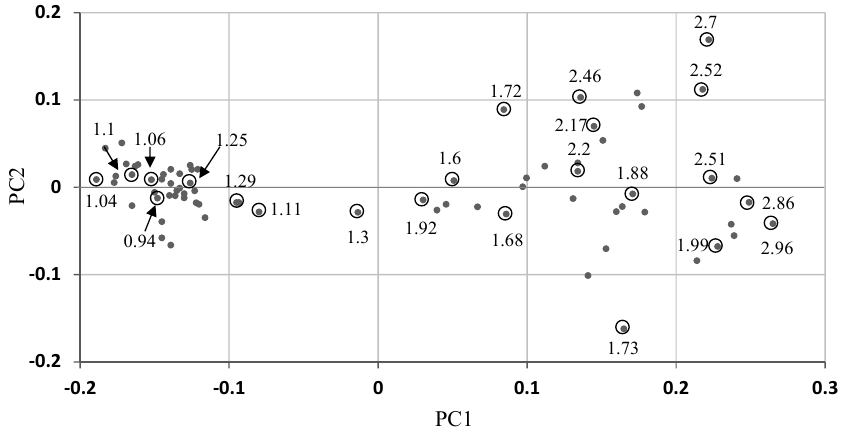
Figure 6. Score plot for partial least squares (PLS) of the Cl model using the slope method. PC, principal component.